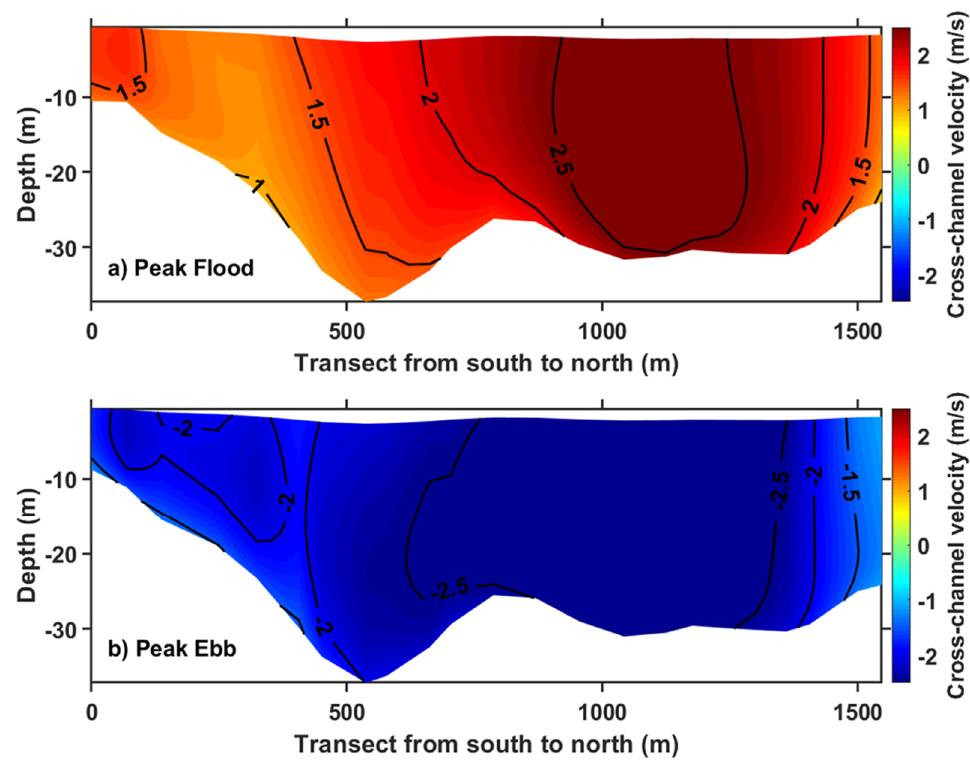
Figure 12. Normal velocity magnitudes at ( a ) the peak flood and ( b ) peak ebb tides along cross section XS4 in Head Harbor Passage. Positive velocity is toward the reader. The cross-section location is shown in Figure 1.